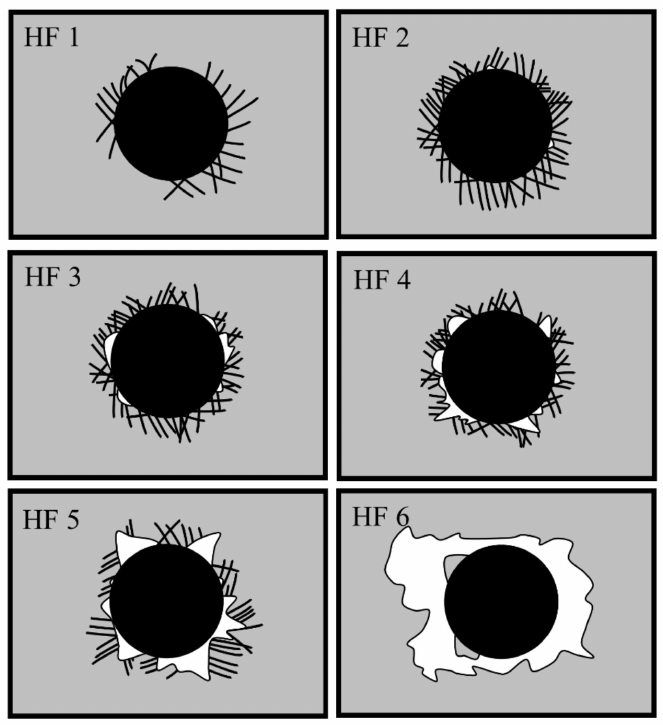
Figure 6. Comparison of the indentation bond